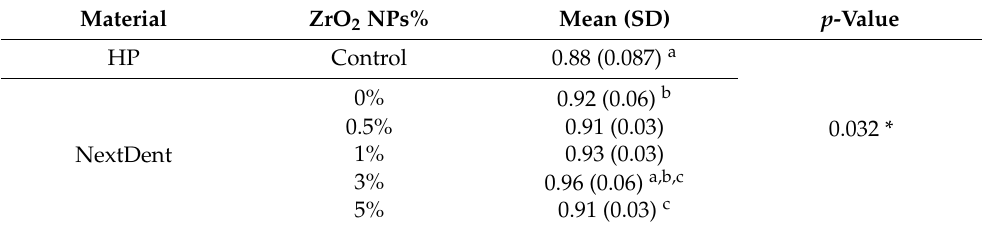
Table 1. Mean, SD, and significance of surface roughness ( µ m).